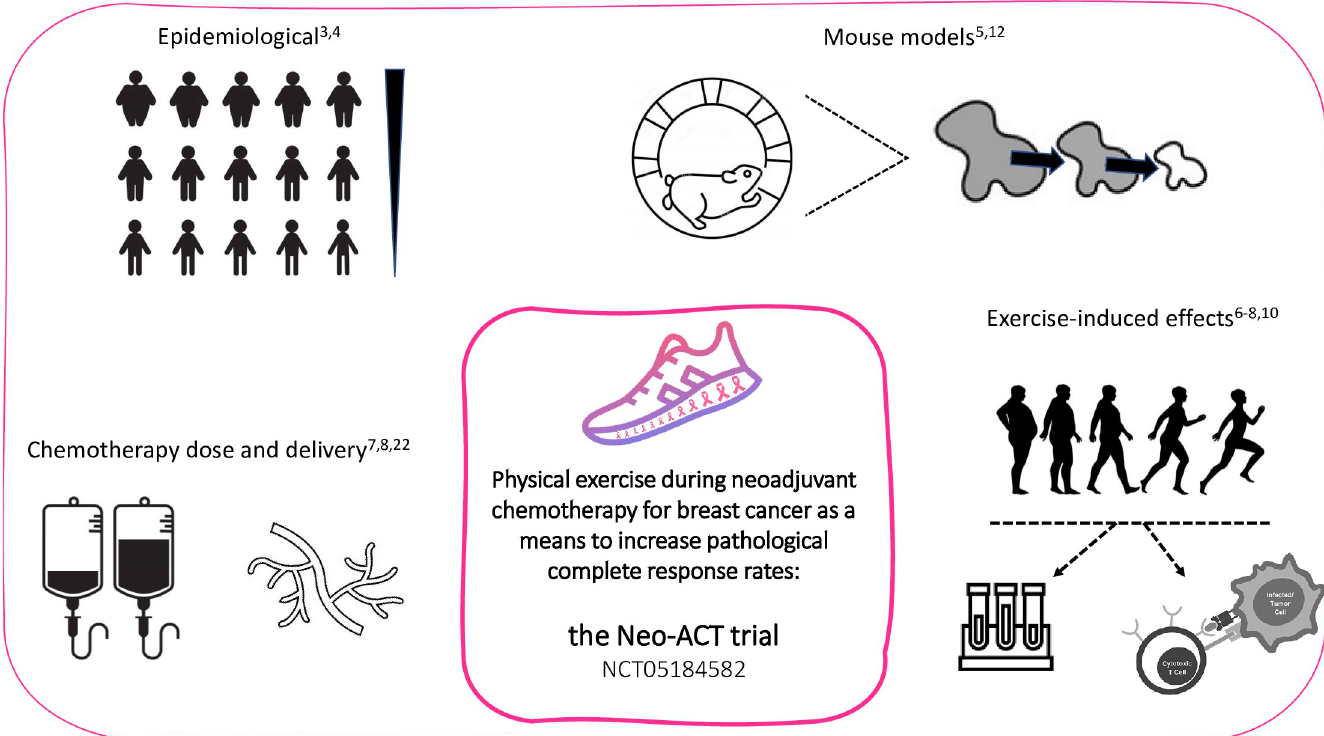
Fig 3. Schematic presentation of published evidence regarding physical activity and breast cancer.